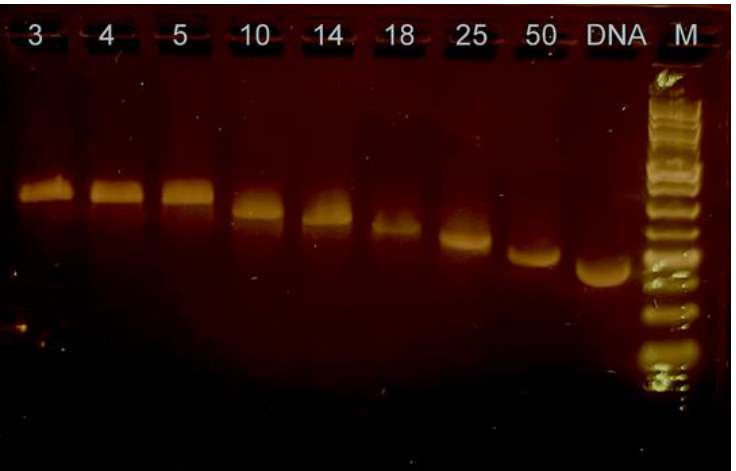
Figure 2. Agarose gel analysis of complexation of gVp with the circular ssDNA from the fd phage. The numbers above lanes indicate the ratio of nucleotides to protein monomers. The gel was stained with SYBR TM GOLD (Invitrogen, Waltham, MA, USA). ‘DNA’ indicates the lane with fd ssDNA in the absence of protein. ‘M’ indicates the lane with the DNA ladder (GeneDireX, Taoyuan, Taiwan) with bands corresponding from bottom to top to 0.250, 0.5, 0.75, 1.0, 1.5, 2.0, 2.5, 3.0, 4.0, 5.0, 6.0, 8.0, and 10.0 kbp. The image was slightly processed to reduce brightness and increase visibility.